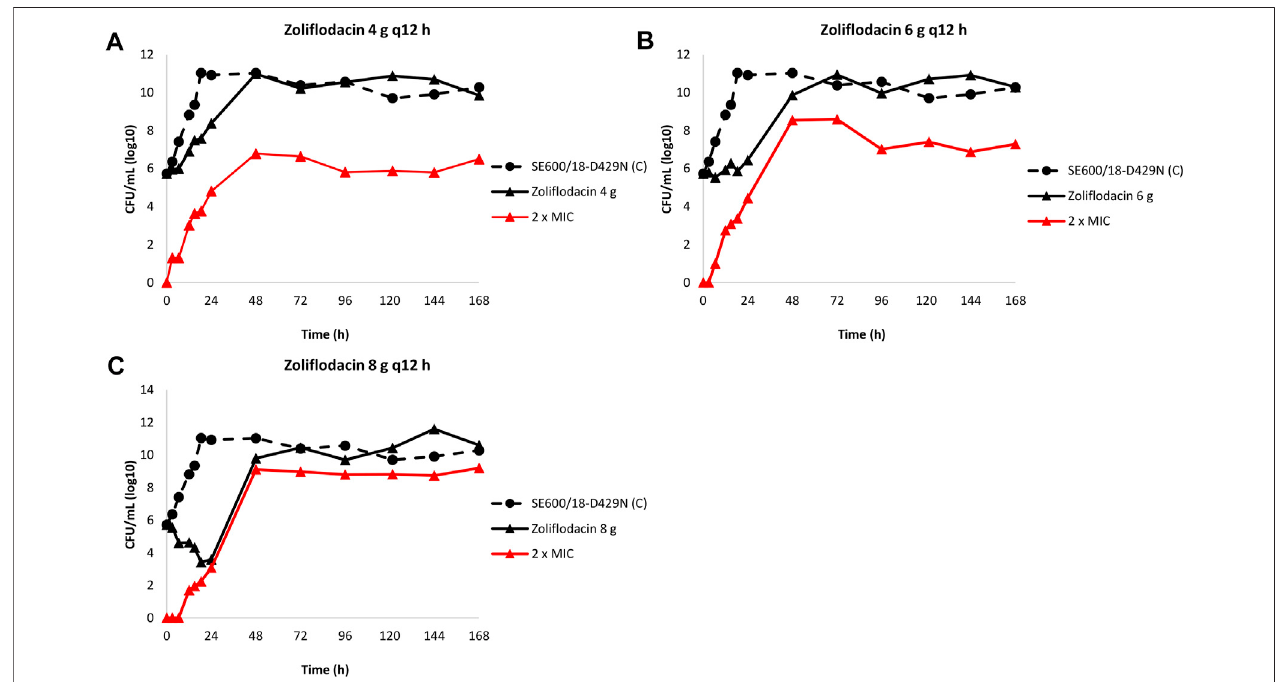
FIGURE3| Growthcurvesofthetotalpopulation ofthezoli fl odacin-resistant Neisseriagonorrhoeae SE600/18-D429N mutant(containingtheGyrBS467Namino acid substitution plus an in vitro selected D429N substitution), inthe dose-range Hollow FiberInfection Model experiment simulating azoli fl odacin oral fractionated dose of 4 g (2 ggiven at 0 and 12 h) (A) , 6 g(3 g given at 0 and 12 h) (B) , and 8 g (4 ggiven at 0 and 12 h) (C) over 24 h and followed for 7 days are shown (black solid lines). Thetotalgrowthofpopulationwithincreasedresistance(redlines)onthezoli fl odacin-containingplates(2×MIC)andtotalgrowthoftheuntreated control(C;black dashed line) are also shown for each treatment.